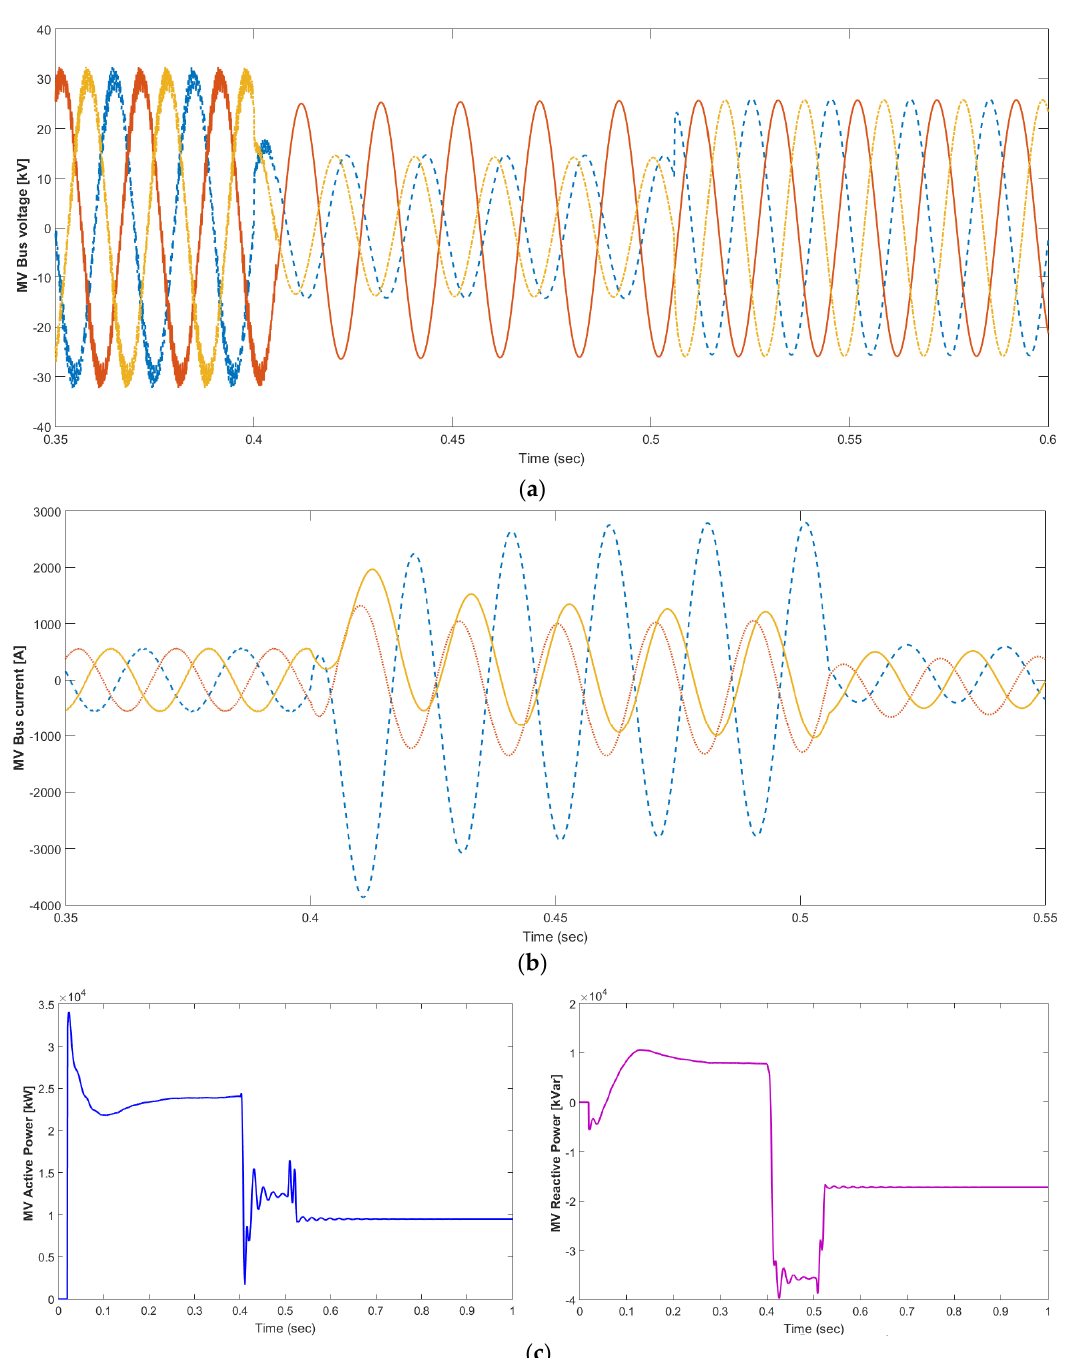
Figure 10. ( a ) Voltages in the MV bus in the case of a one-phase-to-ground fault. ( b ) Currents in the MV park bus in the case of a one-phase-to-ground fault. ( c ) Supplied active and reactive powers of one PV generator at the low-voltage bus during a one-phase-to-ground fault. Every generator had the same response for both active and reactive powers. The delivered active power both before and after the fault is about 448.9 kW. Throughout the fault period, the generators do not supply any active power. The generation unit absorbs 5.5 kVAr before and after the fault. For the duration of the fault, each generator injects 27.56 kVAr to the utility grid. Figure 11 shows the response of the MV bus’s voltage in kV and currents in amperes for the case of the three-phase-to-ground fault. In order to investigate the change in the fault currents and the aggregated contribution, up to 20 MW, of the distributed PV systems, a fault analysis on the 22 kV line was conducted. Figure 11a shows voltages in the MV park bus in the case of a three-phase-to-ground fault in the 22 kV-side, while the power injected at bus 1 in the case of a one-phase-to-ground fault in the 22 kV-side is shown in Figure 11c.